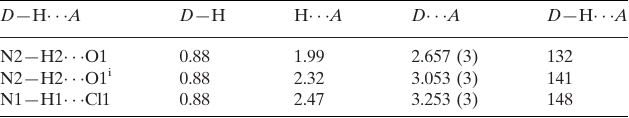
Hydrogen-bond geometry (A˚ , (cid:4)